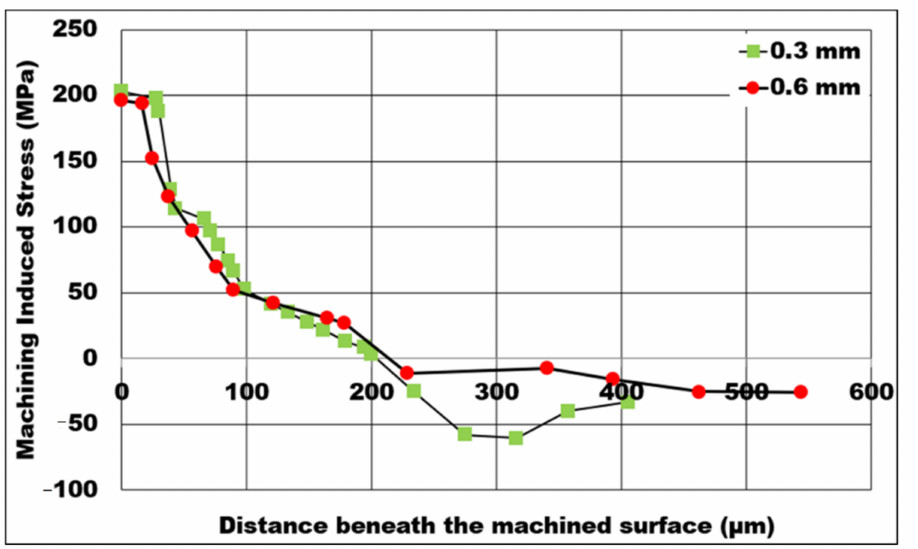
Figure 10. FE simulation of the effect of the average size of hollow alumina shells on the machining-induced stress for 10% volume fraction syntactic foam (Vc = 50 m/min, uncut chip thickness = 0.07